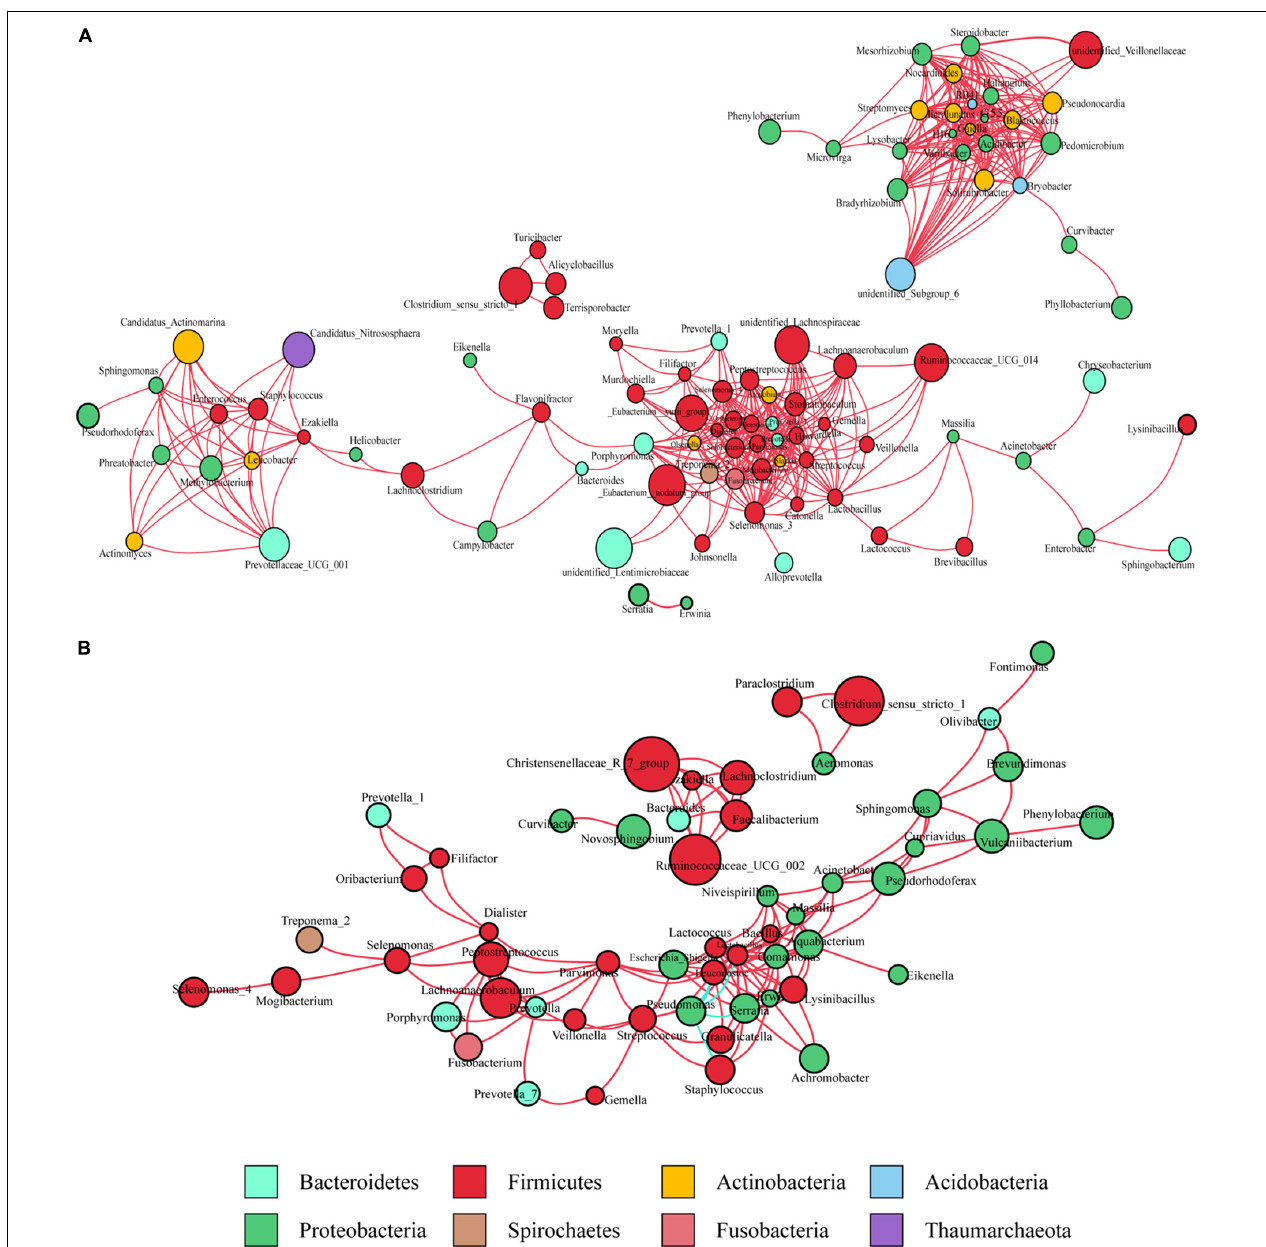
FIGURE 1 | Co-occurrence network analysis of gastric bacterial genera with correlation coefficient > 0.6 or < –0.6 (A) in cancer tissues and (B) non-cancer tissues. The nodes represent different genera, whose colors indicates different phyla. The size of node shows relative abundance of the genus. Positive and negative correlations are drawn in red and blue,